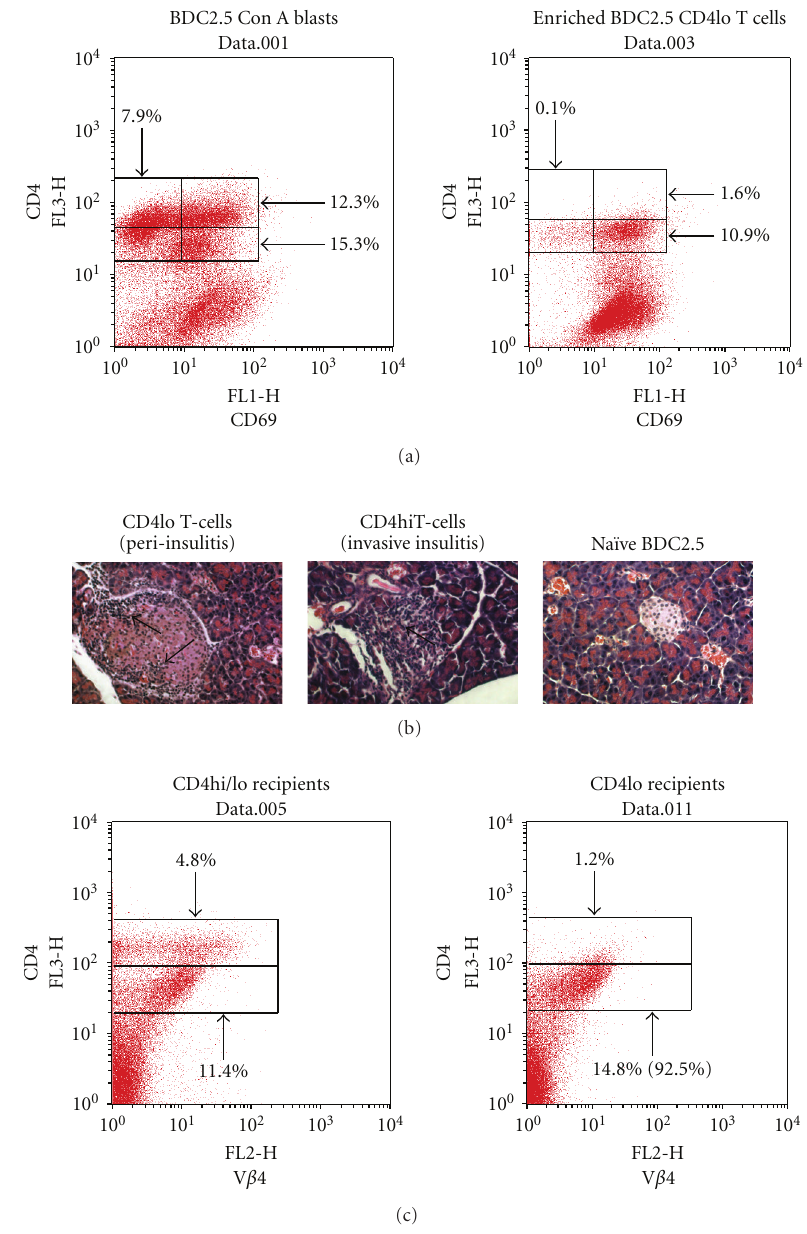
Figure 6: “CD4lo” T cells are present in Con A blasts produced from the spleen cells of NOD.BDC2.5 TCR transgenic mice. (a) Spleen cells from BDC2.5 TCR transgenic mice were stimulated with Con A for 72hrs. The cells were then layered onto Ficol-Histopaque and centrifuged to recover an enriched population of the smaller “CD4lo” population. The Con A blasts and the enriched “CD4lo” population were cultured overnight in IL-2-supplemented medium and then stained with anti-CD4-PE and anti-CD69 FITC for FACS analysis. The numbers in the dot plots indicate the percentage of total cells that are within a region. A total of 20,000 events were collected for each plot. (b) 5 × 10 6 “CD4lo”-enriched or “CD4hi”-enriched T cells were each adoptively transferred into 6 NOD.scid mice. As a control, untreated BDC2.5 TCR Tg spleen cells were also transferred into a control group of NOD.scid mice. Ten days later the pancreas was recovered from at least two mice per group, fixed, embedded, and cut into 5 micron sections that were subsequently stained with hematoxylin and eosin. The sections were viewed and photographed by a blinded observer. At least 50 islets were counted for each group to evaluate the pattern of insulitis. The arrows point to areas of inflammation, peri-insulits, which was predominant in “CD4lo” T cell recipients, and invasive insulitis, which was representative of most islets in recipients of “CD4hi” T cell recipients. The remaining mice were monitored for the development of diabetes as described in the Methods. (c) Spleen cells were recovered from the recipients in (b), stained with anti-CD4-PE and anti-TCR V beta 4-FITC, and then 100,000 events were collected during FACS analysis. The data in the dot plot were gated on viable cells (FSC × SSC). The numbers indicate the percentage of cells in the region. The number in the parentheses for the “CD4lo” recipients indicates the percentage of “CD4lo” cells in the total CD4 +